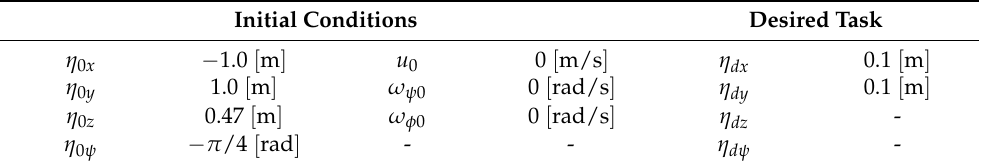
Table 4. Desired task and initial parameters.